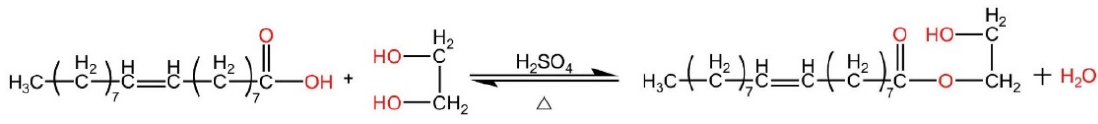
Figure 5. Equation for the esterification of oleic acid with ethylene glycol.